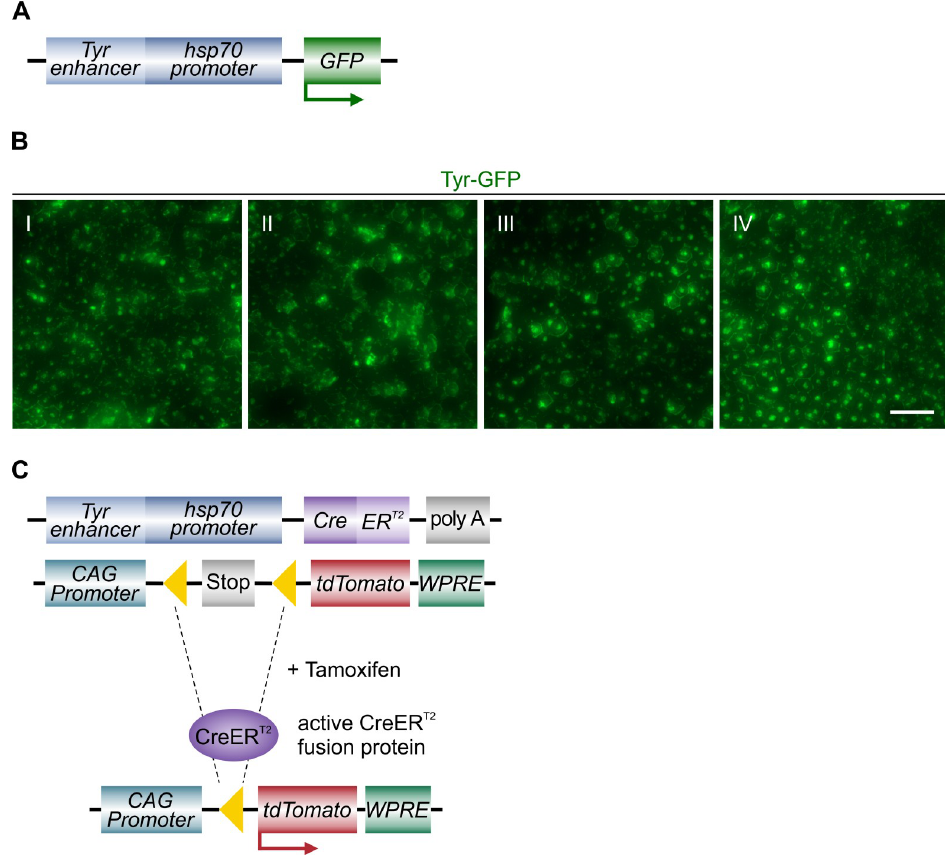
Fig 1. Generation of tamoxifen-inducible Cre transgenic mice. A: Schematic of the RPE-specific Tyr-GFP construct used for generation of Tyr-GFP mice. B: Regional examples (I-IV) of Tyr-GFP expression showing comprehensive expression of GFP under control of the Tyr promoter. Images taken from the flatmount shown in S1 Fig. C: Schematic of the induction of Cre activity in double transgenic mice. Mice harboring the RPE-Tyrosinase-CreEr T2 cassette and the Ai14 cassette are treated with tamoxifen to induce Cre activity. Following recombination, the floxed exons (yellow triangles) are excised. In the case of the Ai14 cassette, recombination removes a stop sequence allowing for expression of tdTomato. Scale bar: (B) 50 μ